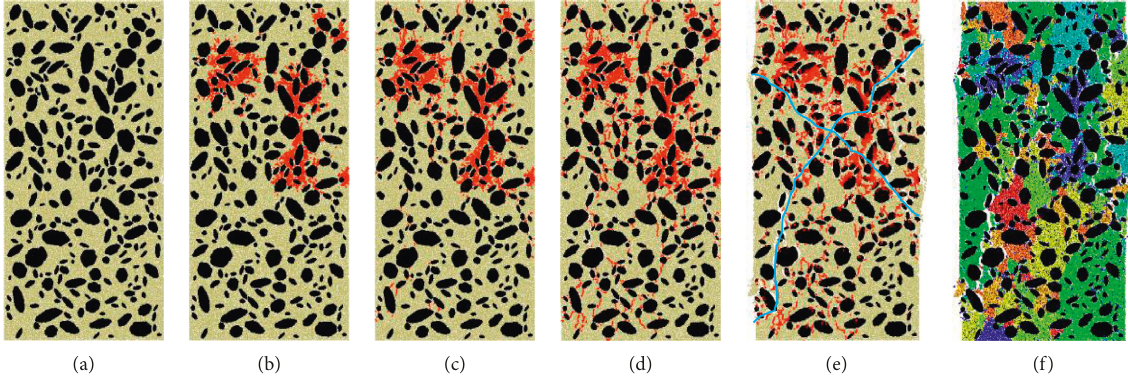
Figure 6: Expanding of bond failure between particles with increase of uniformly distributed loading. (a) 0kPa. (b) 50 kPa. (c) 100kPa. (d) 120kPa. (e) 132kPa. (f) Destroyed.